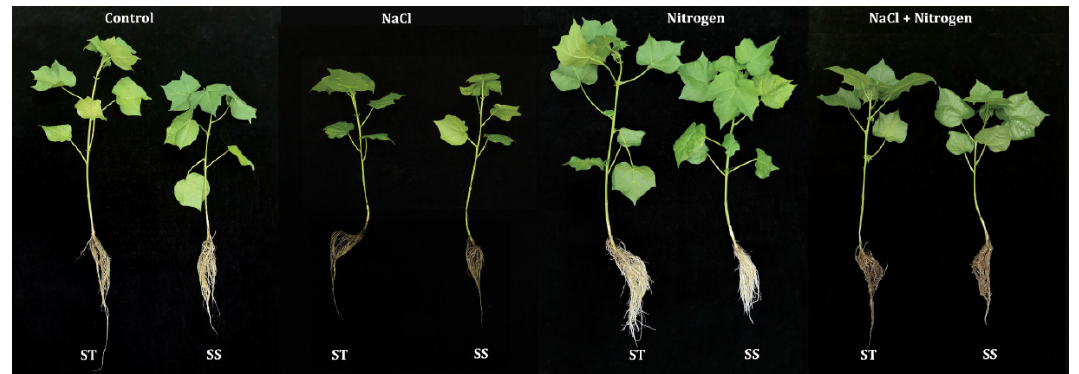
Figure 1. Morphological representation of cotton genotypes under different treatments.